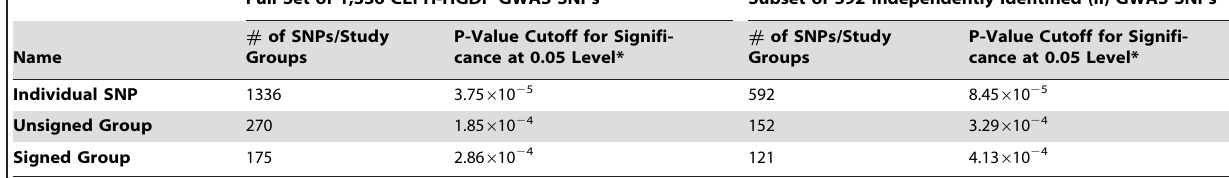
Table 2. Number of SNPs/study groups tested in each analysis.